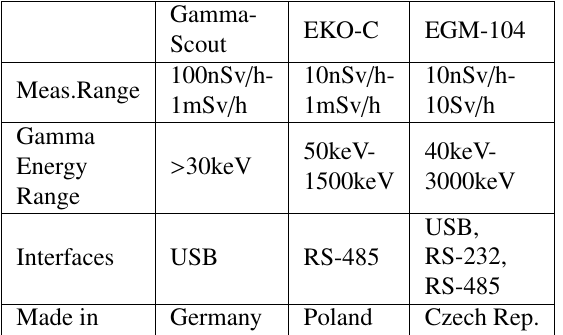
Table 1. Main information about detectors.